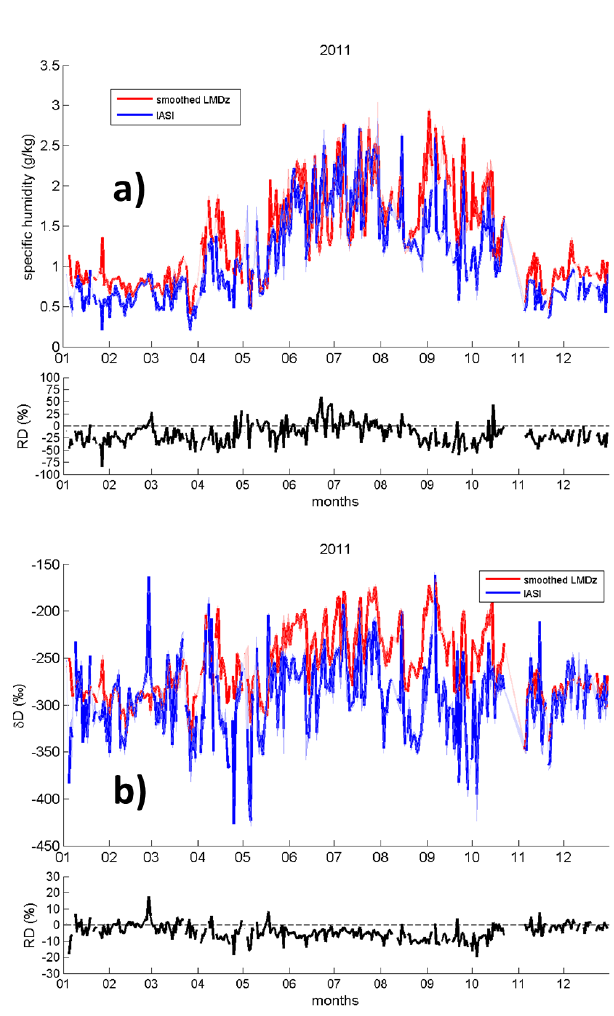
Figure 9. As Fig. 8, for [1–5km] with a | 1T | <